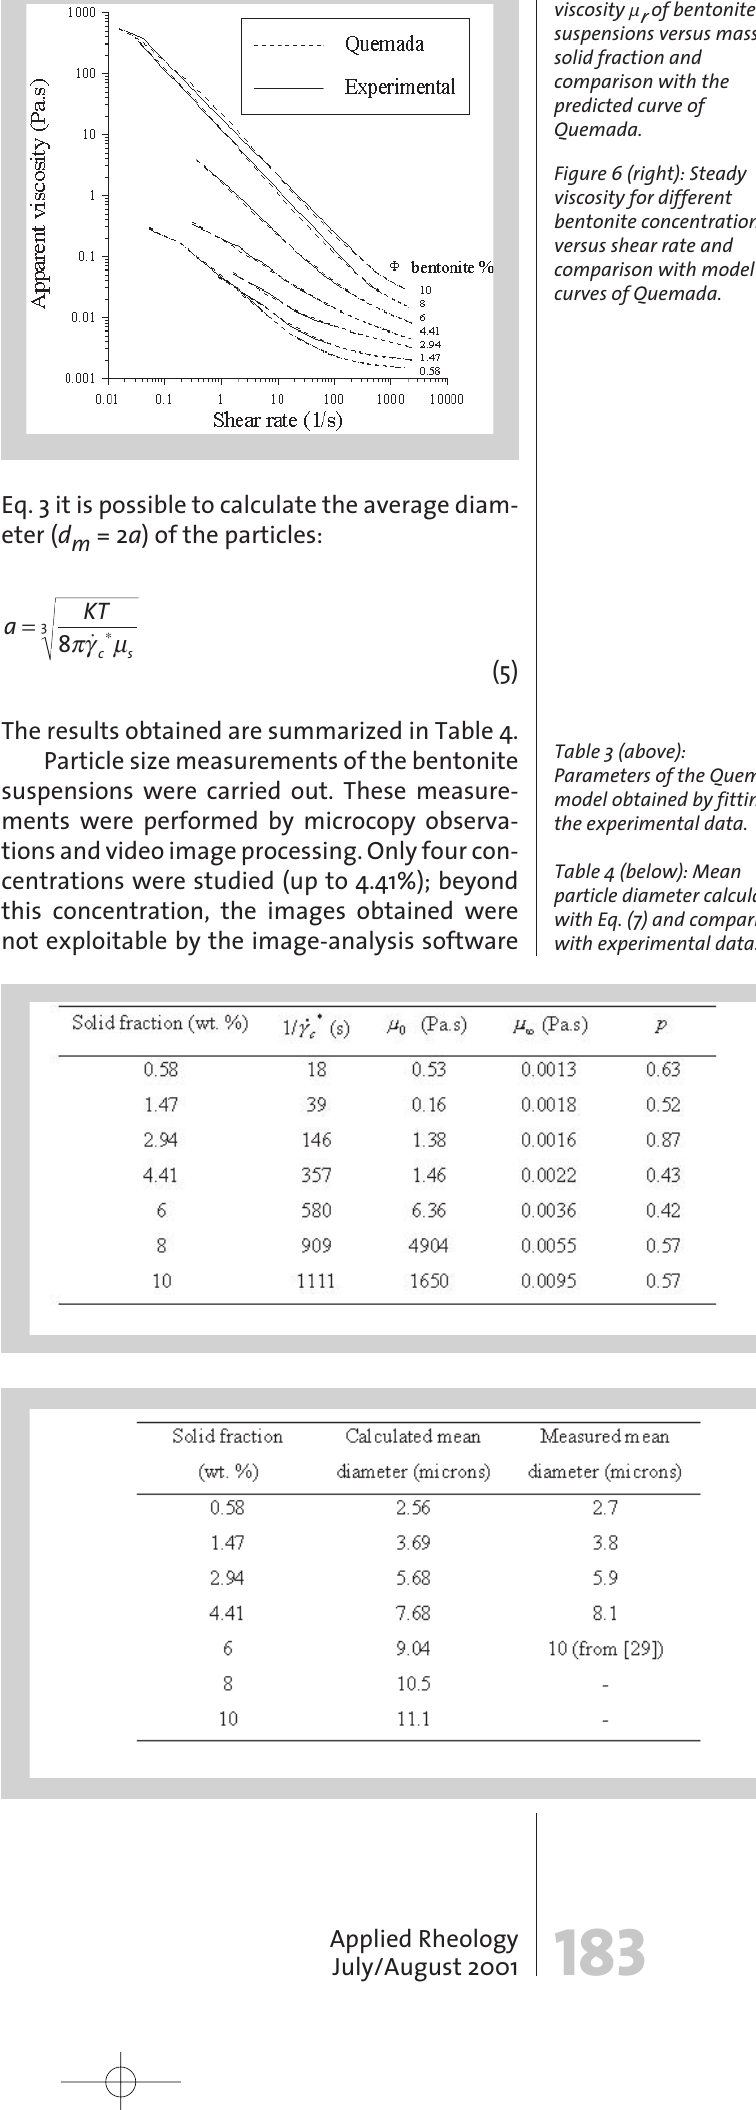
Figure 5 (left): Relative viscosity m rof bentonite suspensions versus mass solid fraction and comparison with the predicted curve of Quemada. Figure 6 (right): Steady viscosity for different bentonite concentrations versus shear rate and comparison with model curves of Quemada.